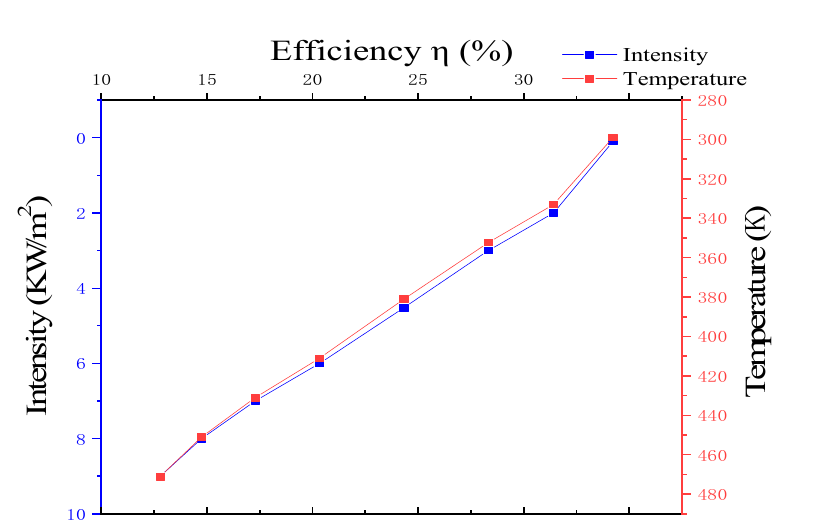
Figure 1. Schematic diagram of LC.